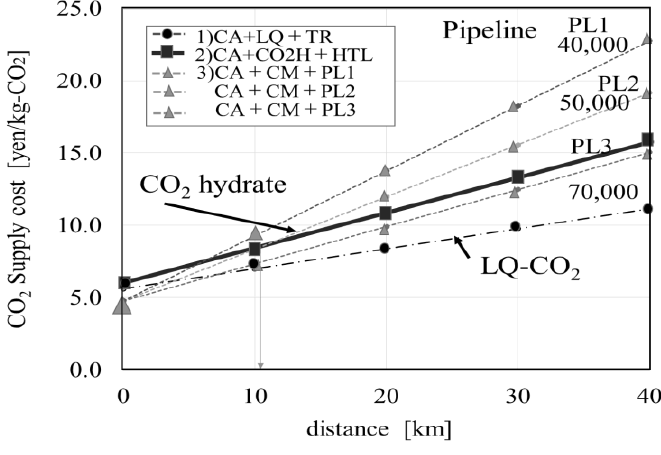
Figure 9. Relation between the total cost of the CO 2 supply system and the transported distance of CO 2 for each method.